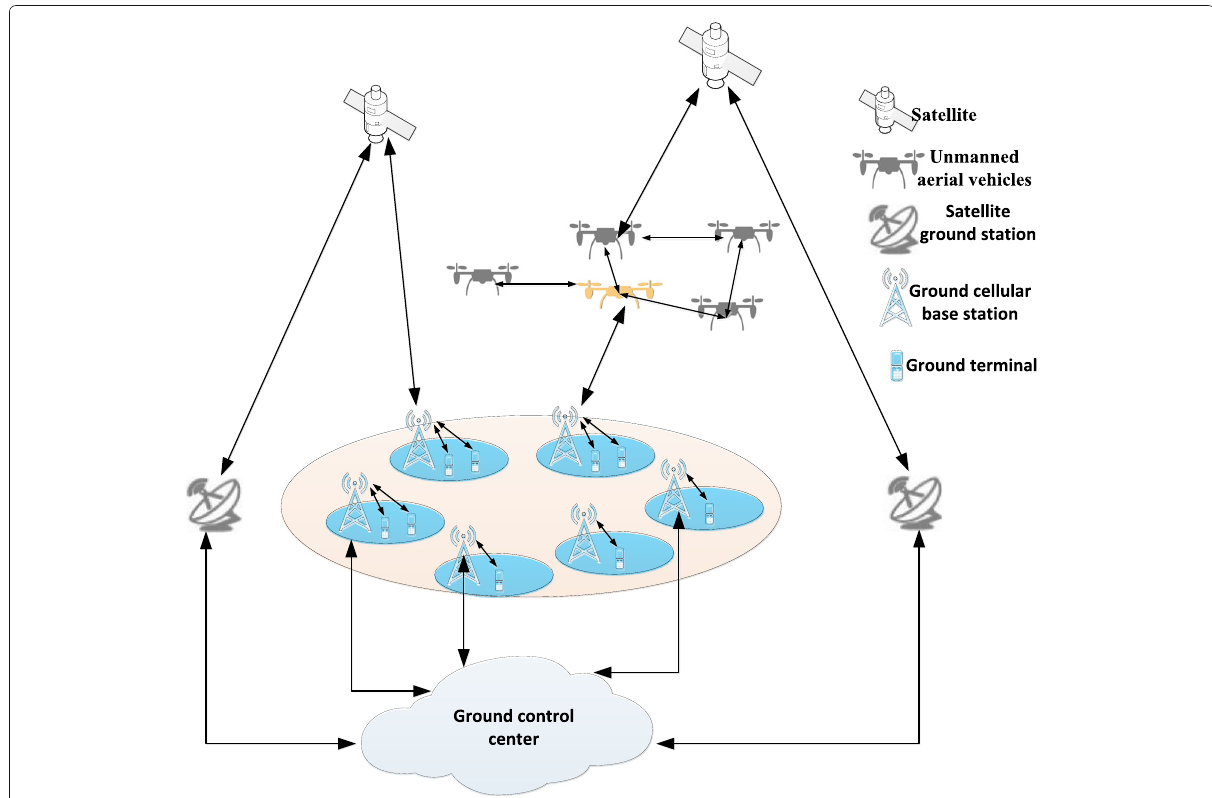
Fig. 1 Illustration of space information networks